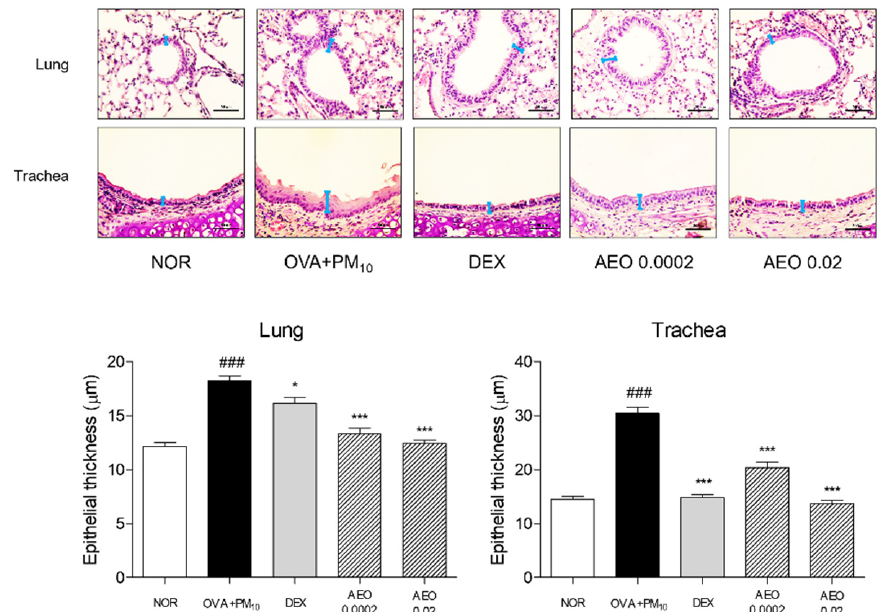
Figure 2. Histological structural changes in lung and trachea tissues stained by hematoxylin and eosin. Magnification is × 400. Blue bars indicate the epithelial thicknesses of lung and trachea tissues, respectively. Results are presented as mean ± standard error of the mean. ### p < 0.001 vs. NOR group; * p < 0.05 and *** p < 0.001 vs. OVA+PM 10 group.